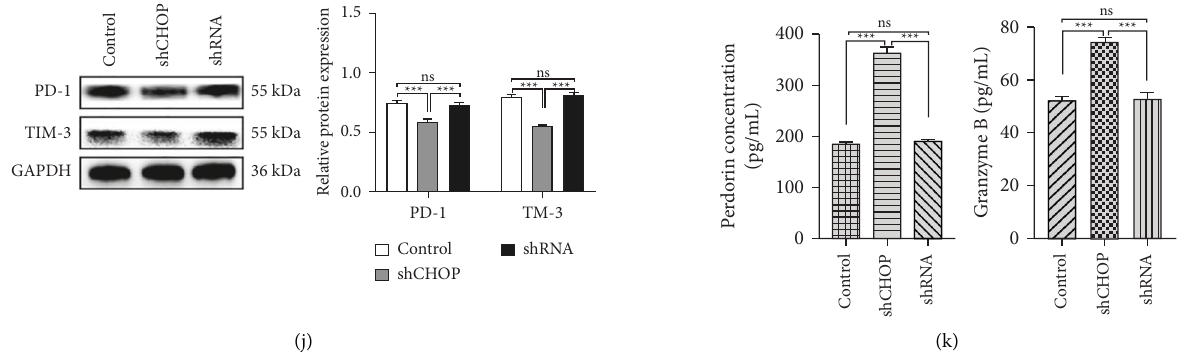
Figure 4: CTLs depletion was induced through the ER stress PERK-CHOP pathway. After coculturing hepatoma cells with CTLL-2 cells, (a) western blotting was used to examine the expression of PERK, P-PERK, and CHOP. (b) TM-induced protein expression of PERK, P- PERK, and CHOP. (c) 4-PBA treatment induced a reduction in PERK, P-PERK, and CHOP protein levels. (d) Cells were cocultured for one day and CTLL-2 cells were treated with either GSK2656157 (0, 10, 50 and 100 nM) for one day. Western blotting analysis of ER stress- associated protein expression. (e) Electron microscopic analysis (scale bar � 2 μ m). (f) Protein expression of PD-1 and TIM-3 in CTLL- 2cells. (g) Expression of PRF1 and GzmB in CTLL-2 cells. (h) Expression of ER stress-associated proteins in CTLL-2 cells after one day of silencing CHOP plasmid (0 and 0.25 μ g/ μ L) treatment. (i) ER morphology was detected by electron microscopy (scale bar � 2 μ m). (j) Western blotting and (k) ELISA analysis. Data are presented as the means ± SD. ∗∗∗ P < 0 . 001, ns indicates no statistical